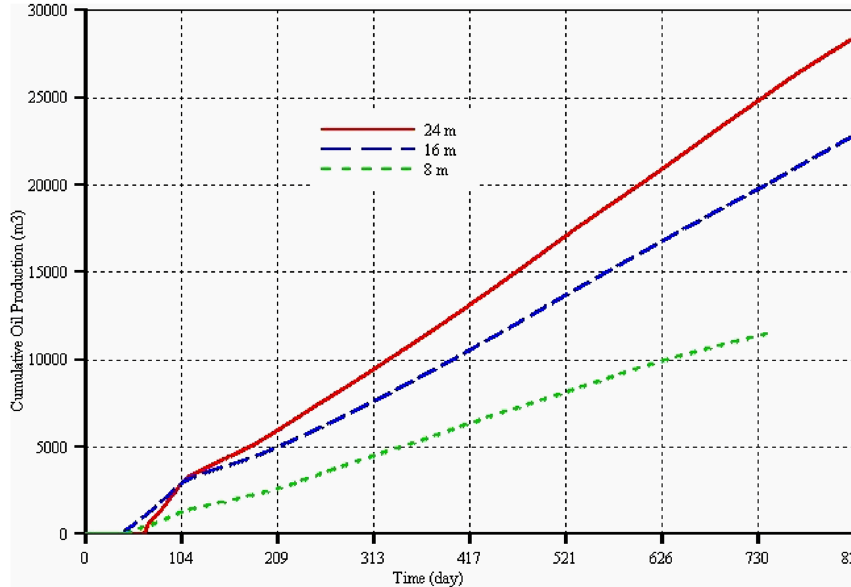
Fig. 7 Cumulative oil produc- tion for the different reservoir thicknesses at constant air injec- tion